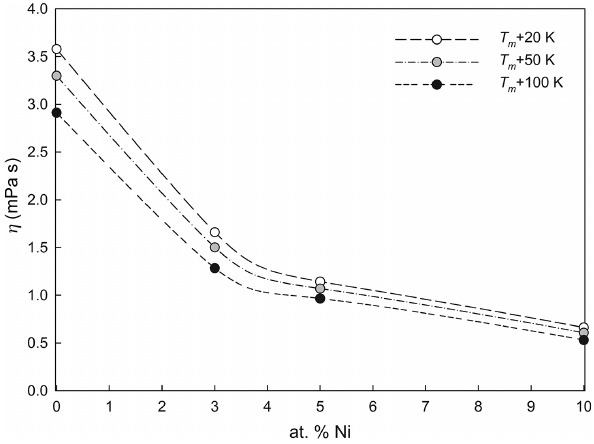
Figure 4: Influence of Ni on the viscosity of liquid Al 2 Cu compound at the temperatures on 20, 50 and 100 K above the melting point ( T m